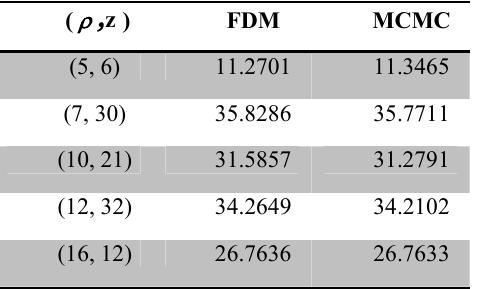
Table 4: Results Comparison between FDM and MCMC for Problems with Mixed Boundary